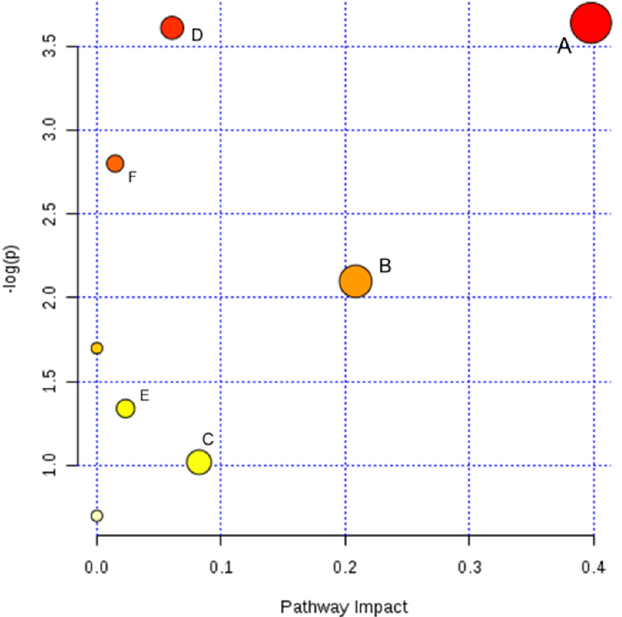
Figure 4. The metabolic pathways related to headache, as analyzed by MetaboAnalyst. The map was generated using the 379 reference map by KEGG. (A) Glutathione metabolism; (B) Nicotinate and nicotinamide metabolism; (C) Arginine and proline metabolism; (D) Purine metabolism; (E) Glycerophospholipid metabolism; (F) Tryptophan metabolism.